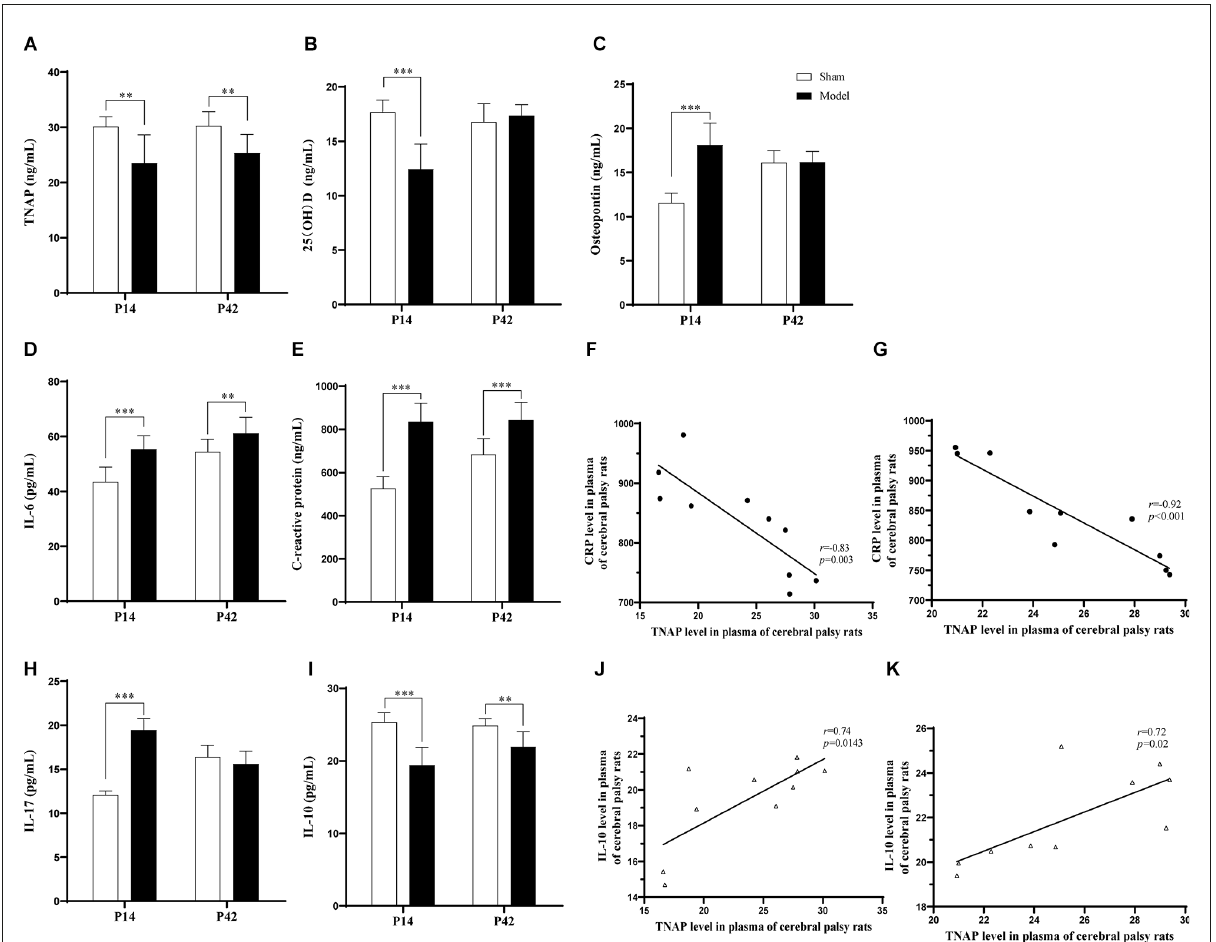
FIGURE5 (A,B,I) Seven days after HIE modeling, compared with those in the Sham group, the levels of TNAP ( p = 0.001, n = 10), 25 (OH)D ( p < 0.001, n = 10), and IL-10 ( p < 0.001, n = 10) were significantly reduced in the Model group. (C–E,H) The levels of OPN, IL-6, CRP, and IL-17 were significantly greater in the Model group than in the Sham group ( p < 0.001, n = 10). (F,J) Seven days after HIE modeling, the plasma levels of TNAP were positively correlated with those of CRP ( p = 0.003, r = − 0.83, n = 10) and IL-10 ( p = 0.0143, r = 0.74, n = 10). (A,D,E) Thirty-five days after HIE modeling, compared with the Sham group, the Model group had significantly lower levels of TNAP ( p = 0.002, n = 10), IL-6 ( p = 0.009, n = 10), and CRP ( p < 0.001, n = 10), while the level of IL-10 was significantly decreased ( p = 0.001, n = 10). (G,K) Thirty-five days after HIE- modeling, the plasma TNAP were correlated with CRP ( p < 0.001, r = − 0.92, n = 10) and IL-10 ( p = 0.02, r = 0.72, n = 10). ∗∗ p < 0.01 vs. Sham; ∗∗∗ p < 0.001 vs.